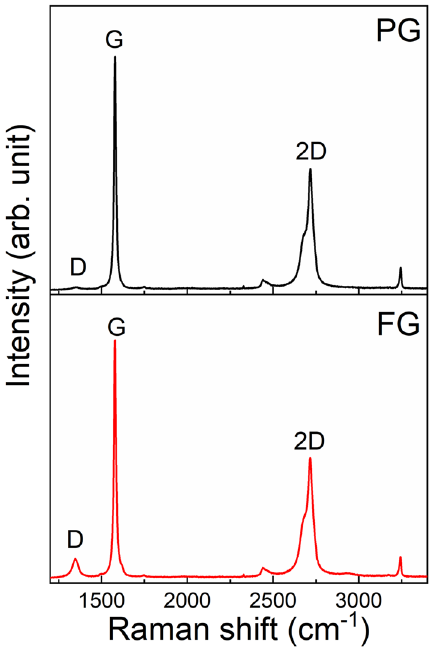
Figure 3. Raman spectra of ( a ) powdered graphite (PG) and ( b ) floated graphite (FG) samples. The D peak appears in FG sample due to the edge